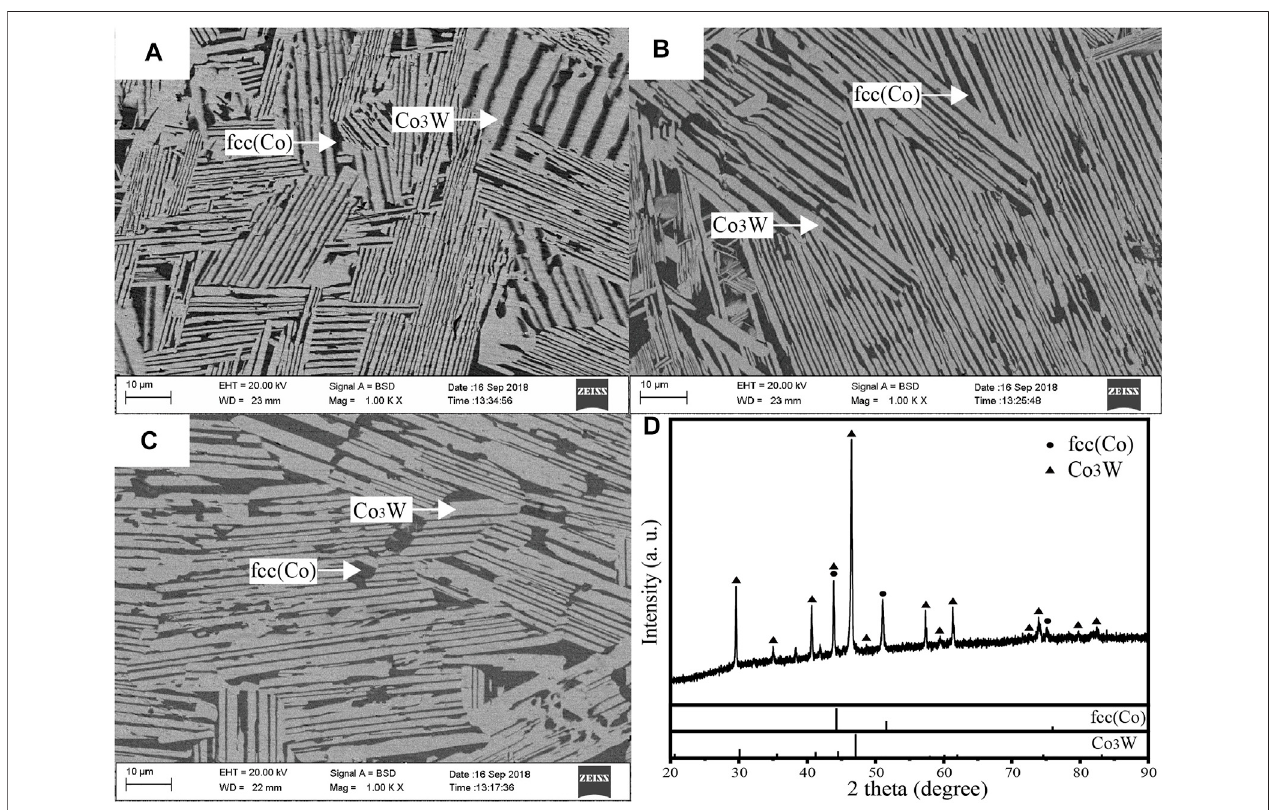
FIGURE 2 | BSE micrographs and XRD patterns of alloys (A) for a1 (B) for a2 (C) and (D) for a3.